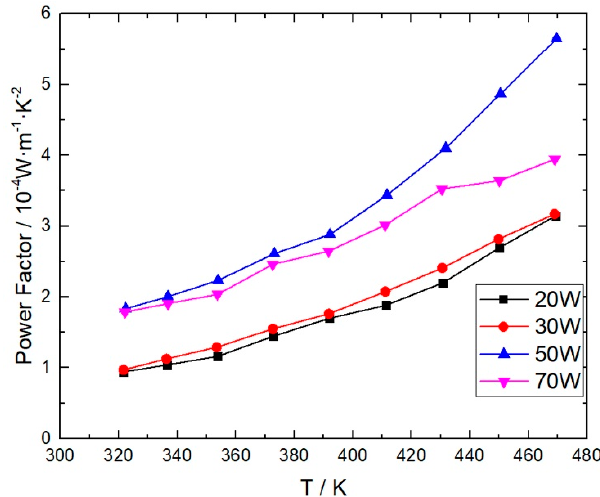
Figure 9. Power factors of the Bi 2 Te 3 films deposited under different powers